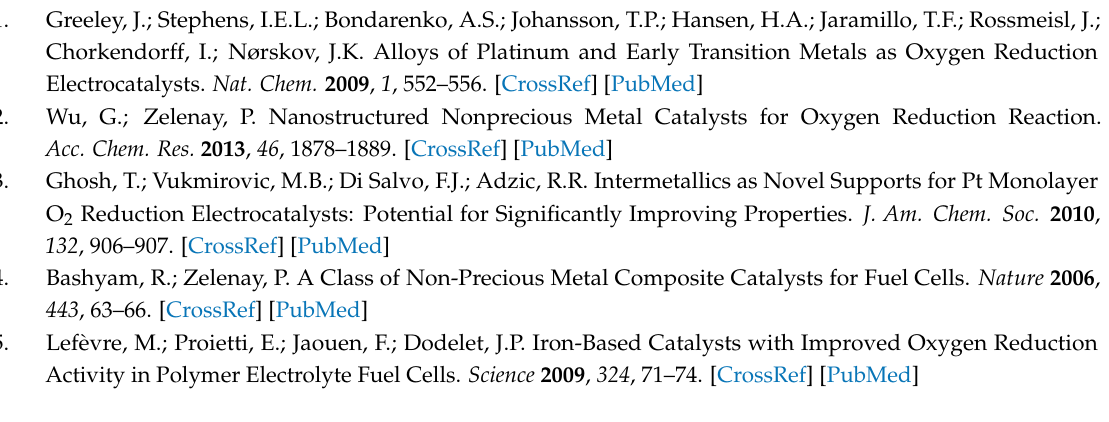
Figure S1: Porosity Distribution. Figure S2: Results of Raman spectra decomposition. Figure S3: XPS survey of S_GA_FeCu. Figure S4: XPS N1s region of S_GA_FeCu. Figure S5: Superimposition of XPS C1s spectra. Figure S6: XPS Fe2p spectra of S_GA_FeCu and S_GA_Fe. Table S1: Parameters inferred from Raman spectra fitting. Table S2: Lattice parameters, weight fraction (WF), average displacement parameters (Umean), and fit residuals for the refinements performed on crystalline